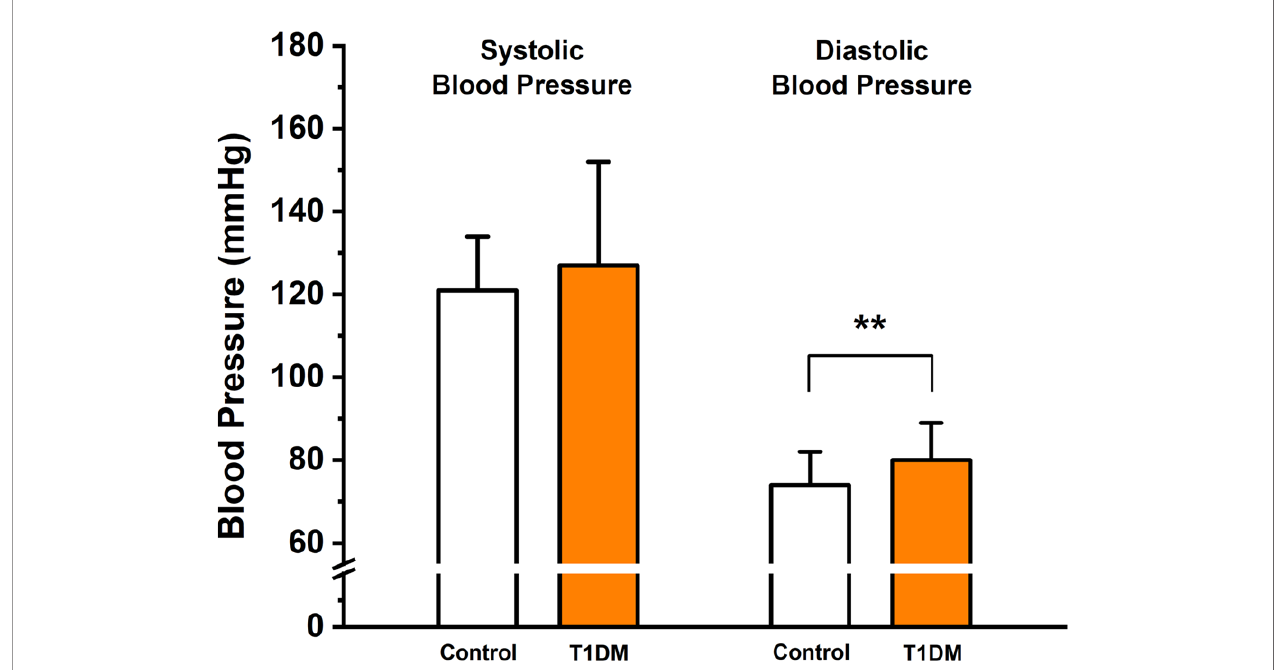
( Table 2 ). Other laboratory parameters (lipid, liver, and blood test pro fi le) did not show any signi fi cant differences. Two- dimensional echocardiography has not revealed any signi fi cant